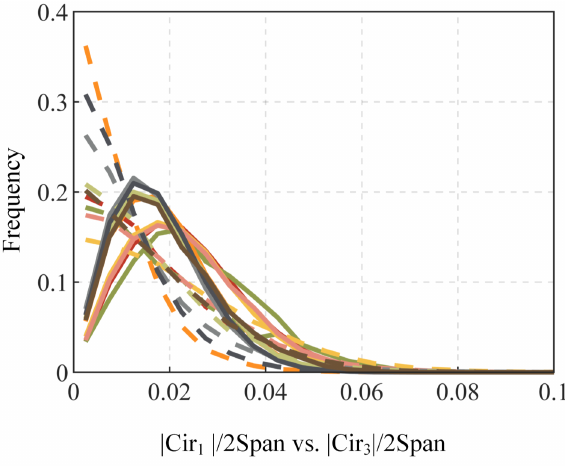
| /2Span (dotted lines) and | Cir 1